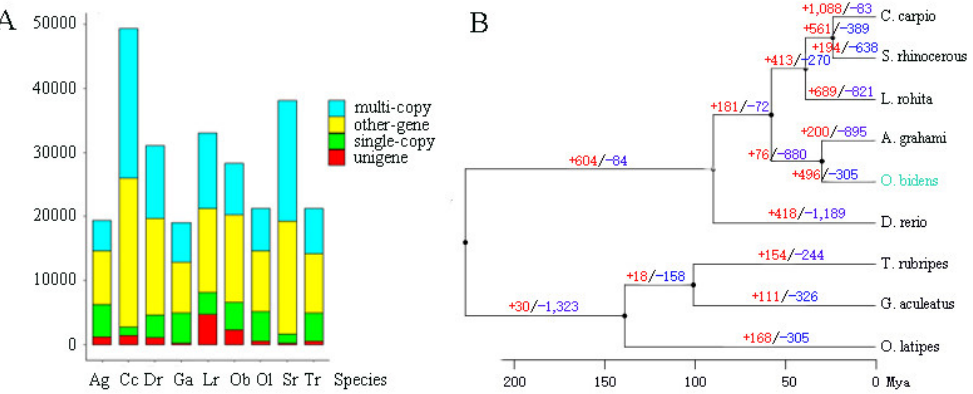
Figure 3. A phylogenetic tree based on single-copy genes from the nine genome sequences. ( A ) The number of orthologous for nine fish species. Names for species are abbreviated to Ag, Anabarilius grahami ; Cc, Cyprinus carpio ; Dr, Danio rerio ; Ga, Gasterosteus aculeatus ; Lr, Labeo rohita ; Ob, Opsariichthys bidens ; Ol, Oryzias latipes ; Sr, Sinocyclocheilus rhinocerous ; Tr, Takifugu rubripes . ( B ) A bayesian phylogenetic tree, gene families, and divergence time of male O. bidens . The bayesian posterior probability and the maximum likelihood bootstrap had support values of 100%. The numbers above the lines indicate gene family expansions (+ and red) and contractions (− and green).